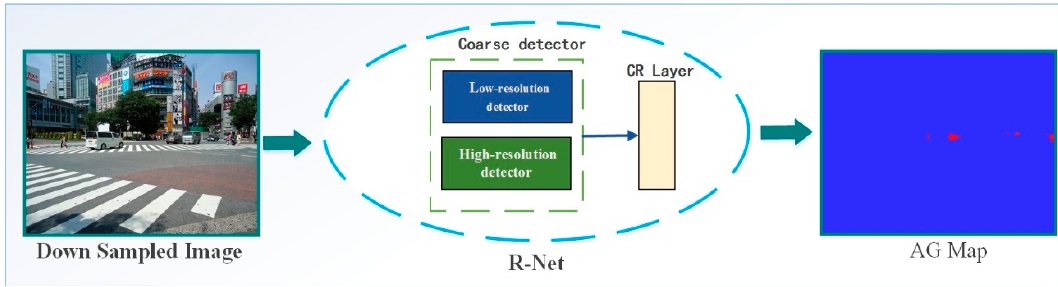
Figure 7. R-Net network framework.